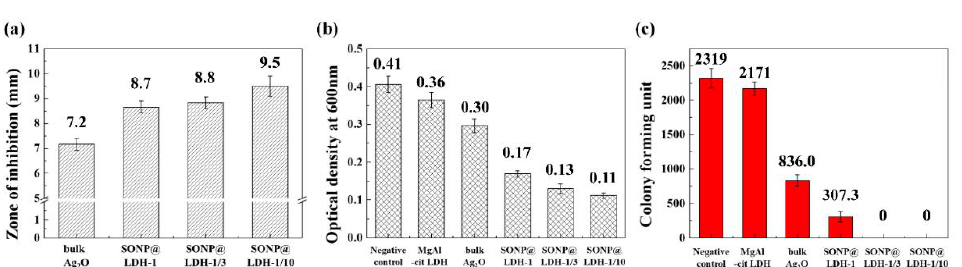
Figure 6. Antibacterial activity investigation by ( a ) zone of inhibition assay on LB agar plate, ( b ) optical density measurement at 600 nm after batch growth in liquid culture and ( c ) colony forming unit test on LB agar plate against Escherichia coli ( E. coli .).